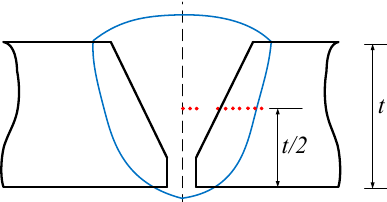
Figure 5. Schematic diagram of hardness test locations.